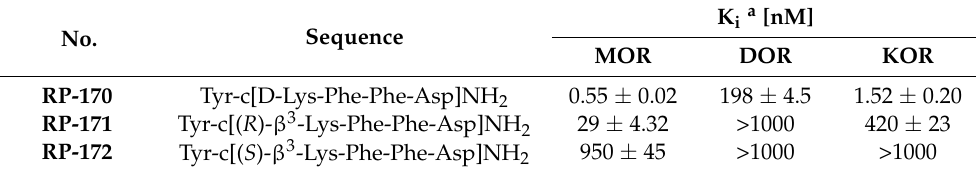
Table 1. Receptor binding affinities (K i ) of novel cyclic analogs at MOR, DOR, KOR. Table 1 . Receptor binding affinities (K i ) of novel cyclic analogs at MOR, DOR, KOR. No.